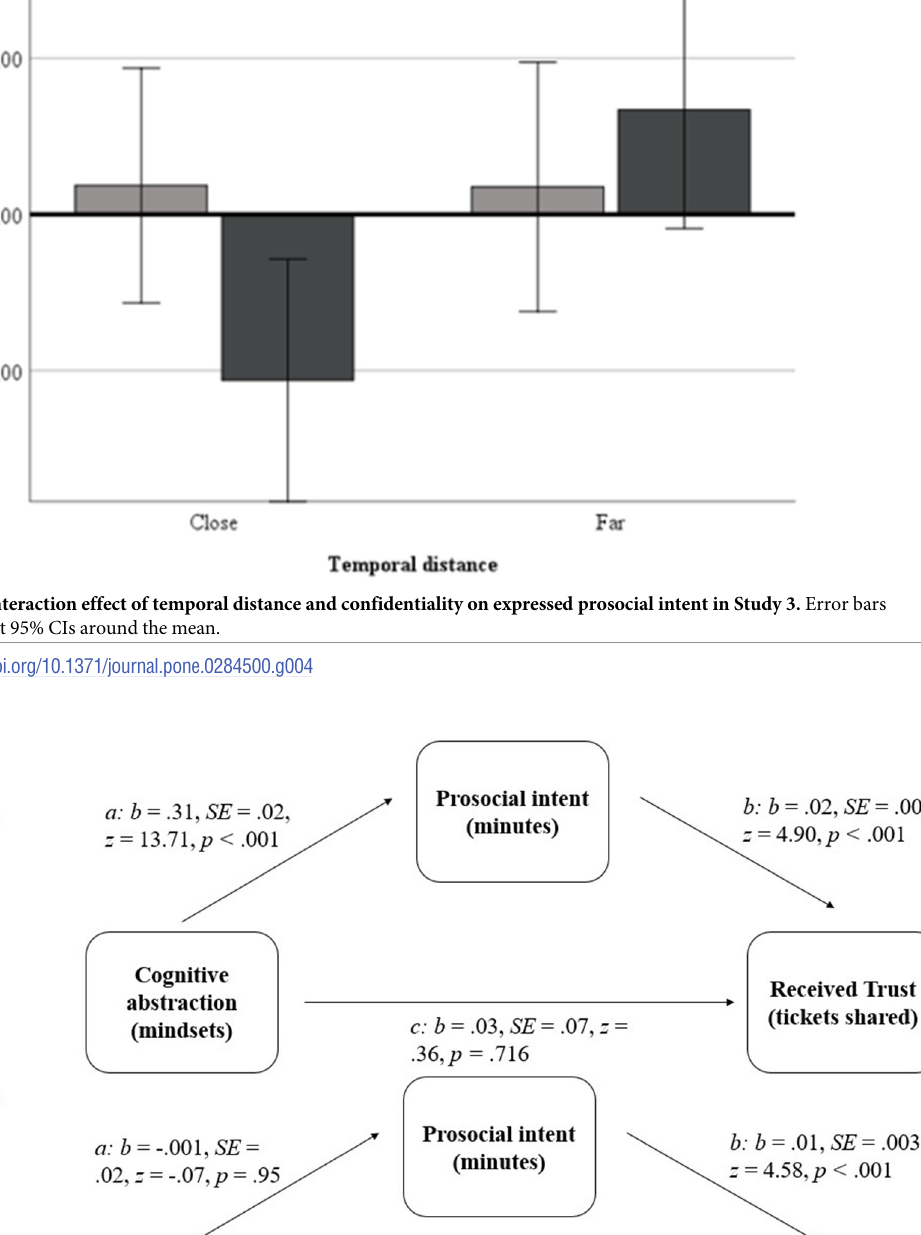
PLOS ONE | https://doi.org/10.1371/journal.pone.0284500 April 14,